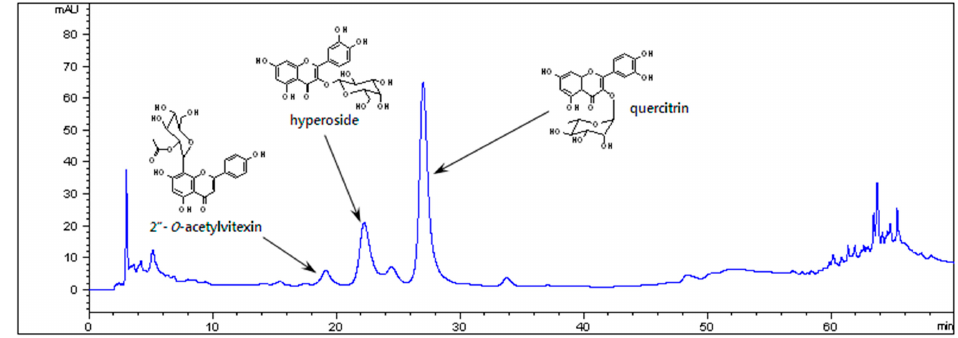
Figure 1. High-Performance Liquid Chromatography (HPLC) chromatogram of ethanol extract of the aerial part of Osteomeles schwerinae (OSSCE).